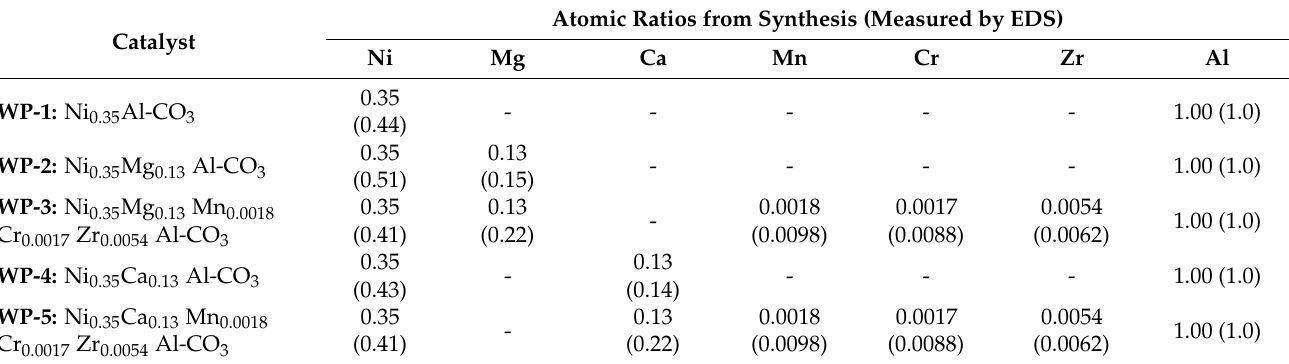
Table 1. Catalysts and atomic ratios of structural elements relative to Al content. Atomic Ratios from Synthesis (Measured by EDS) Catalyst Ni Mg